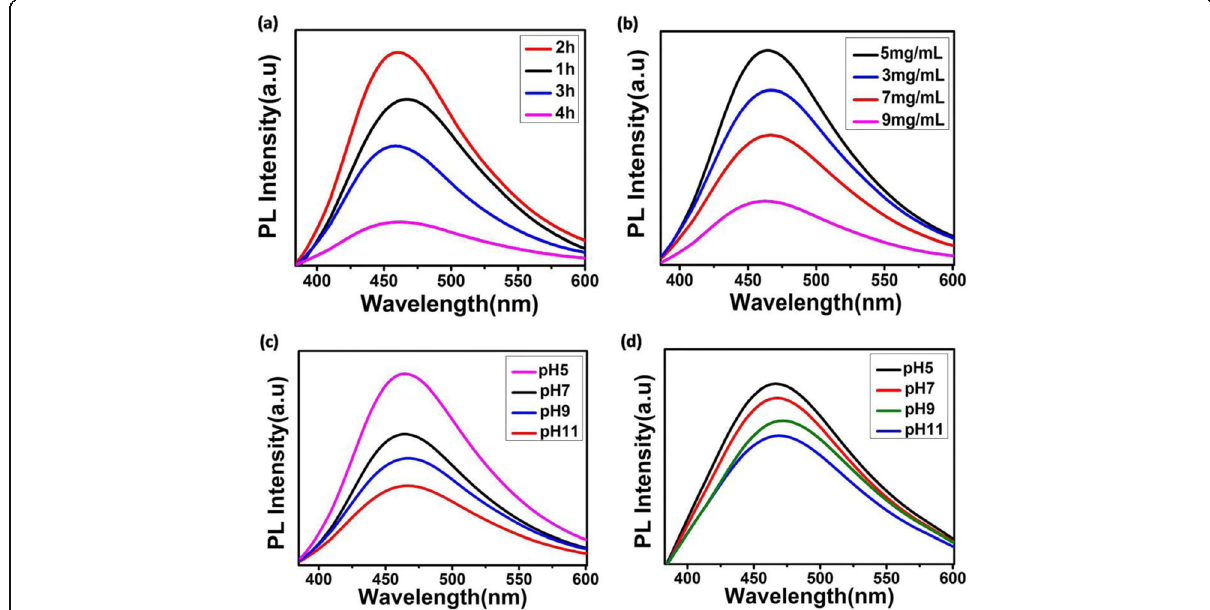
Fig. 3 Photoluminescence spectra of CD-PDA. a Fluorescent intensity of CD-PDA with various duration of dopamine polymerization in Tris buffer.